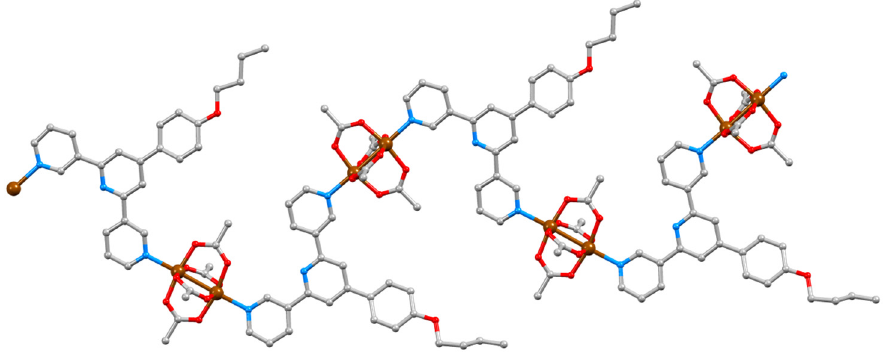
Figure 11. Part of one chain in [2{Cu 2 ( µ -OAc) 4 ( 2 )} · 1.25MeOH] n with a coordination sequence of out / in at each paddle-wheel unit; H atoms and solvent molecules omitted for clarity.